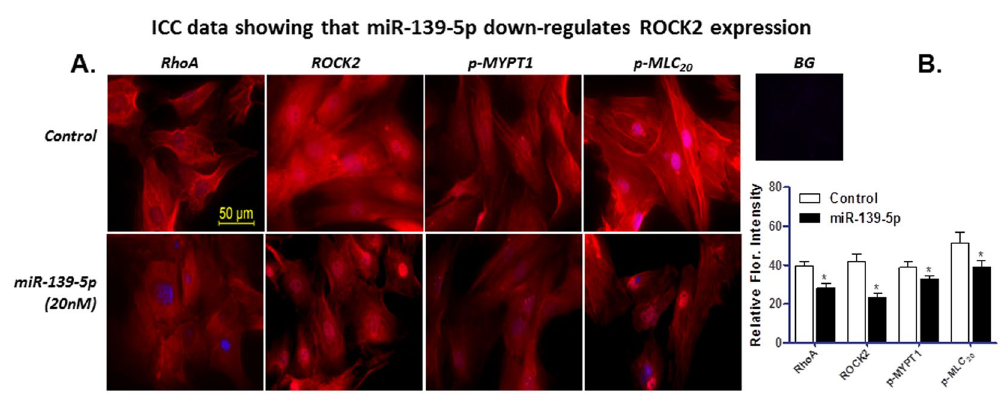
Figure 4. Immunocytochemistry data before and after miRNA-139-5p. ( A ) Immunocytochemical images showing expression of RhoA, ROCK2, p-MYPT1, and p-MLC 20 following transfection of IAS SMCs with miRNA-139-5p. ( B) Quantitative data showing significant ( * p < 0.05) downregulation of immunofluorescence intensity of RhoA, ROCK2, p-MYPT1, and p-MLC 20 in the IAS SMCs following transfection with miRNA- 139-5p as compared with controls (cells treated with scrambled miRNA). BG =